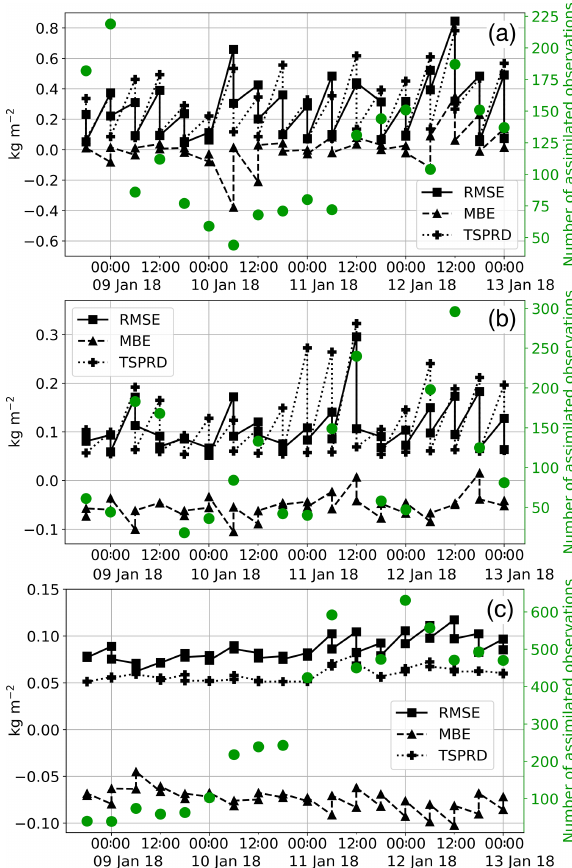
Figure 4. Temporal evolution of ensemble mean first guess and analysis for the three phases IWP at 400hPa (a) , SWP at 500hPa, (b) and LWP at 850hPa (c) for cycling period C (Table 1). The RMSE (rectangles and solid lines), MBE (triangles and dashed lines), and TSPRD (pluses and dotted lines) are shown. The saw- tooth pattern observed is a common feature of such plots in DA. The number of assimilated observations per assimilation time is repre- sented by the green dots.